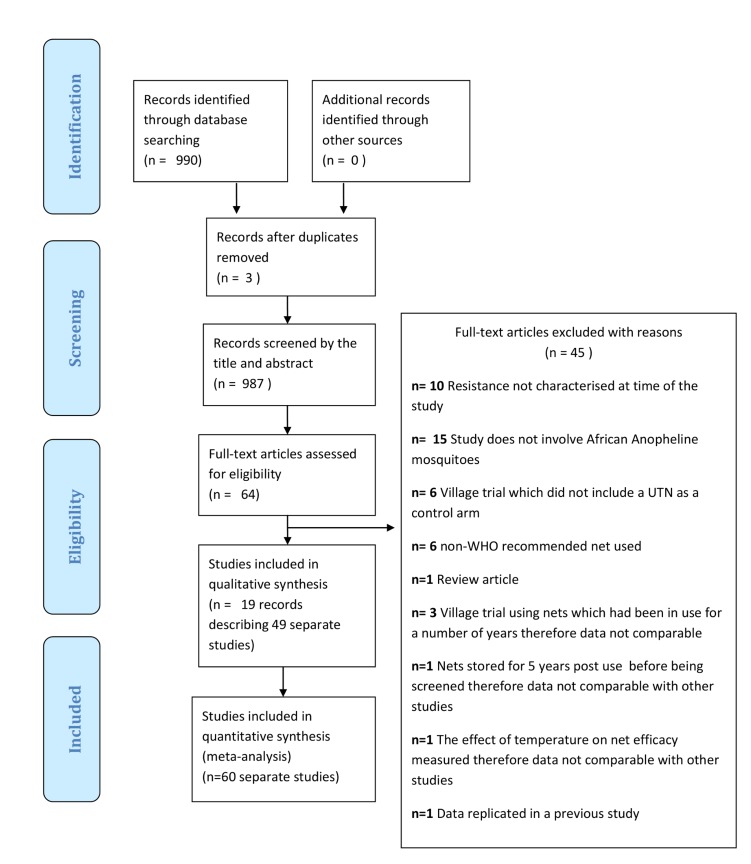
Flow diagram of the study selection process.